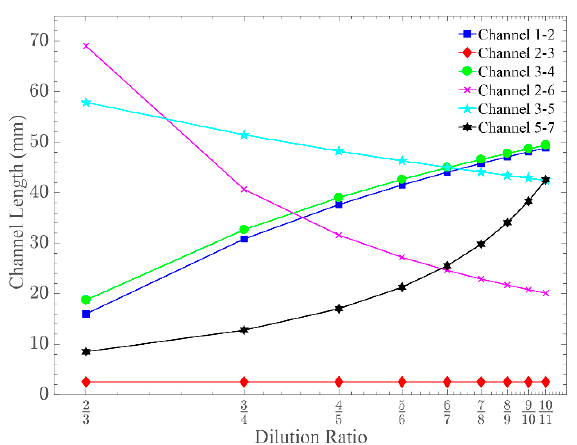
Figure 4. The design rules of the pressure and flow rate balanced modular unit cell showing the required microchannel lengths for various dilution ratios. Microchannel widths are kept the same as the optimised modular unit cell-generating dilution ratio of 2:3.